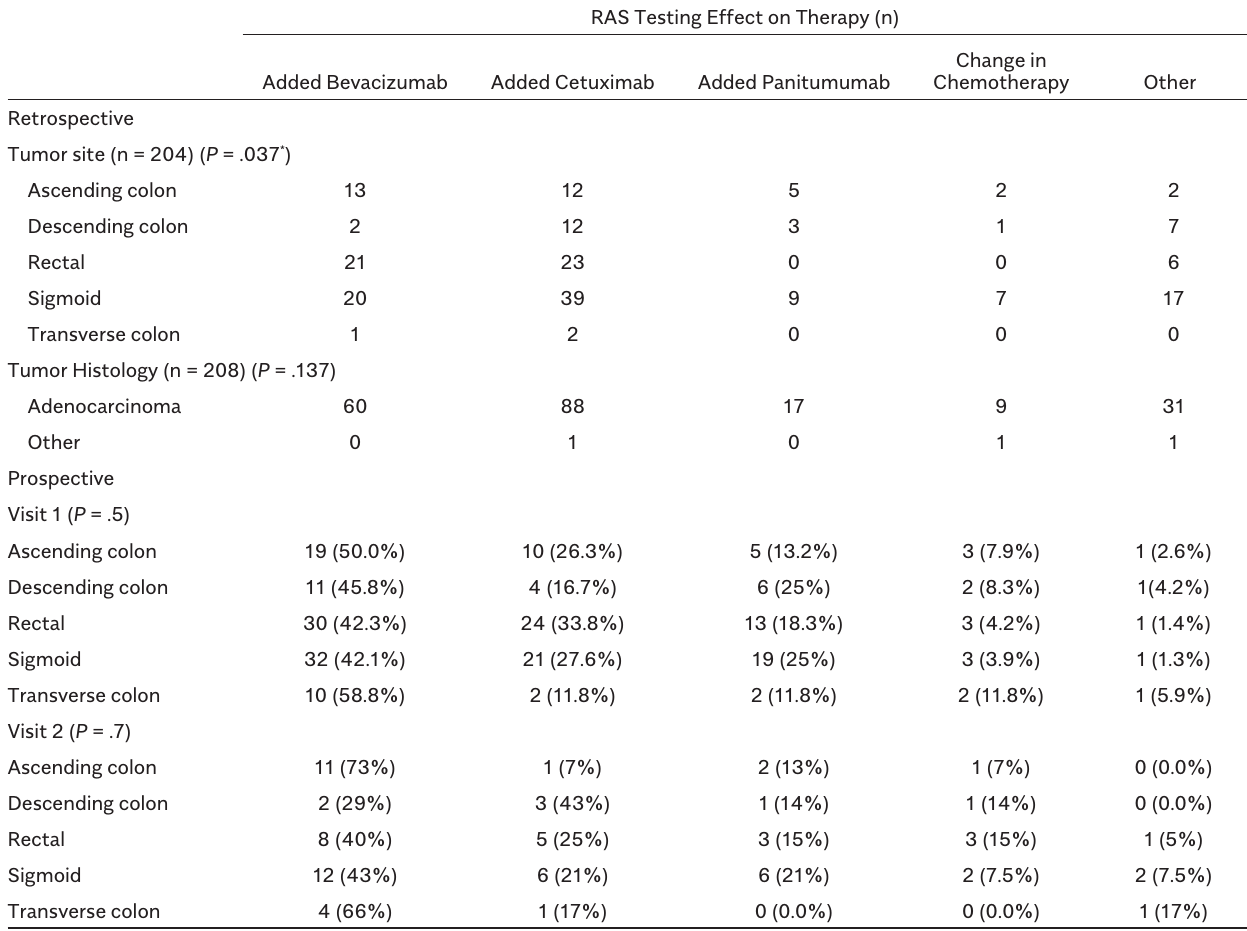
Table 5. Correlation Between Tumor Characteristics and Impact of RAS Status on Therapeutic Strategy RAS Testing Effect on Therapy (n) Added